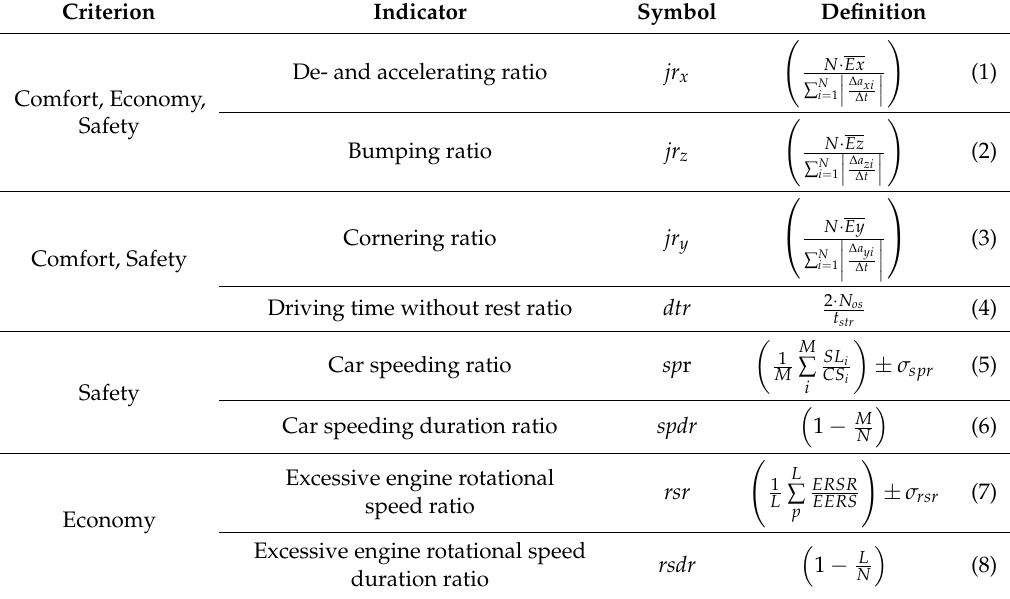
Table 1. The safety , economy and comfort criteria and corresponding indicators, their symbols, units, and definitions. Criterion Indicator Symbol Definition